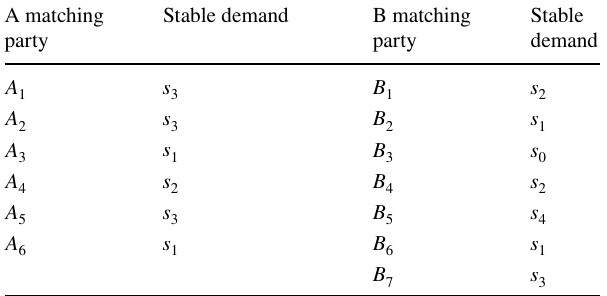
Table 10 The fuzzy stable demands expressed by the individuals in the A matching party and B matching party